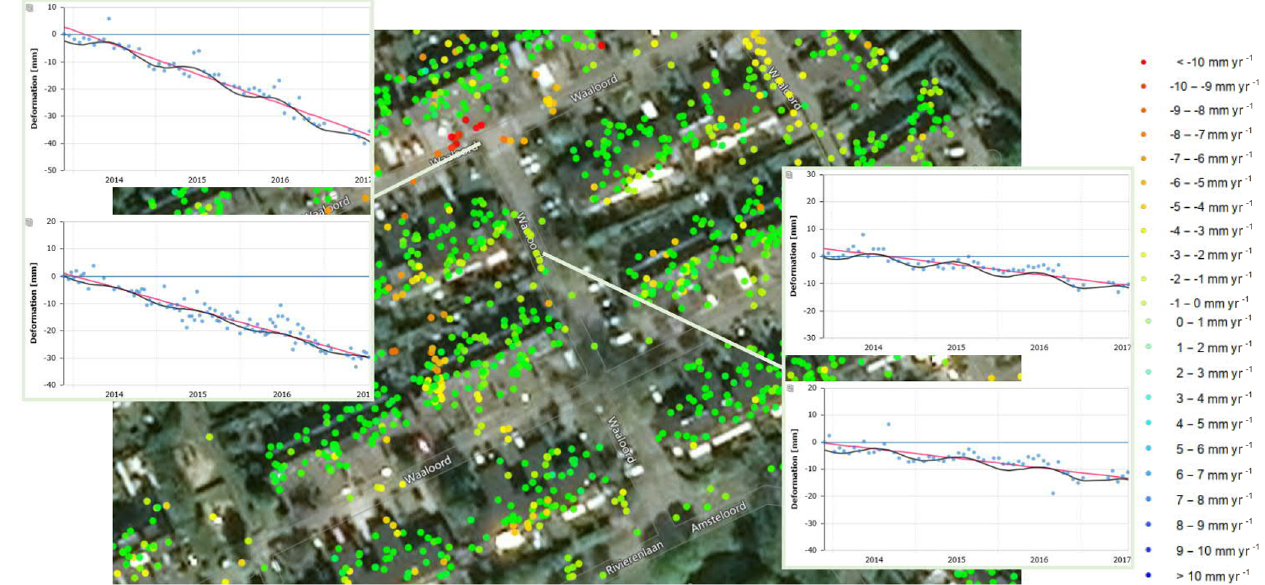
Figure 4. Visualisation of measurement points and trends. Includes material ©2019 SkyGeo Netherlands BV. All rights reserved.